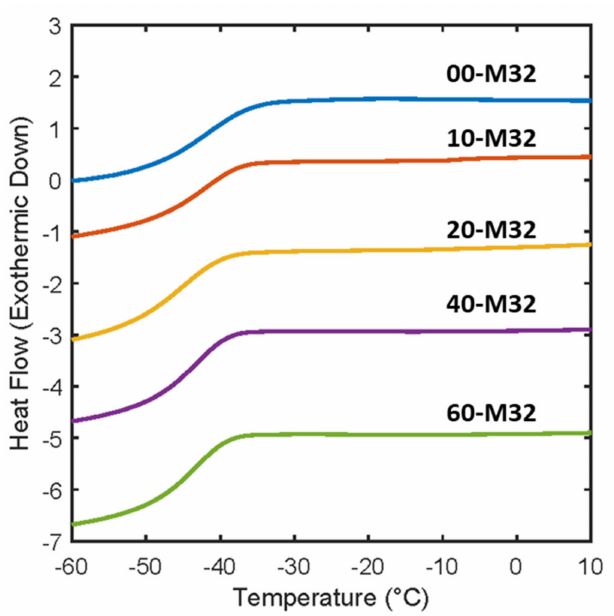
Figure 5. Exemplary differential scanning calorimetry thermograms of PEGDA films with varying pre-polymerization water content at constant